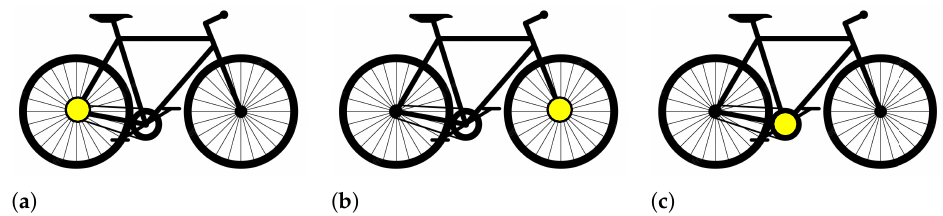
Figure 13. Possible locations of motor on e-bikes. ( a ) Front wheel hub-motor. ( b ) Rear wheel hub-motor. ( c ) Mid-drive